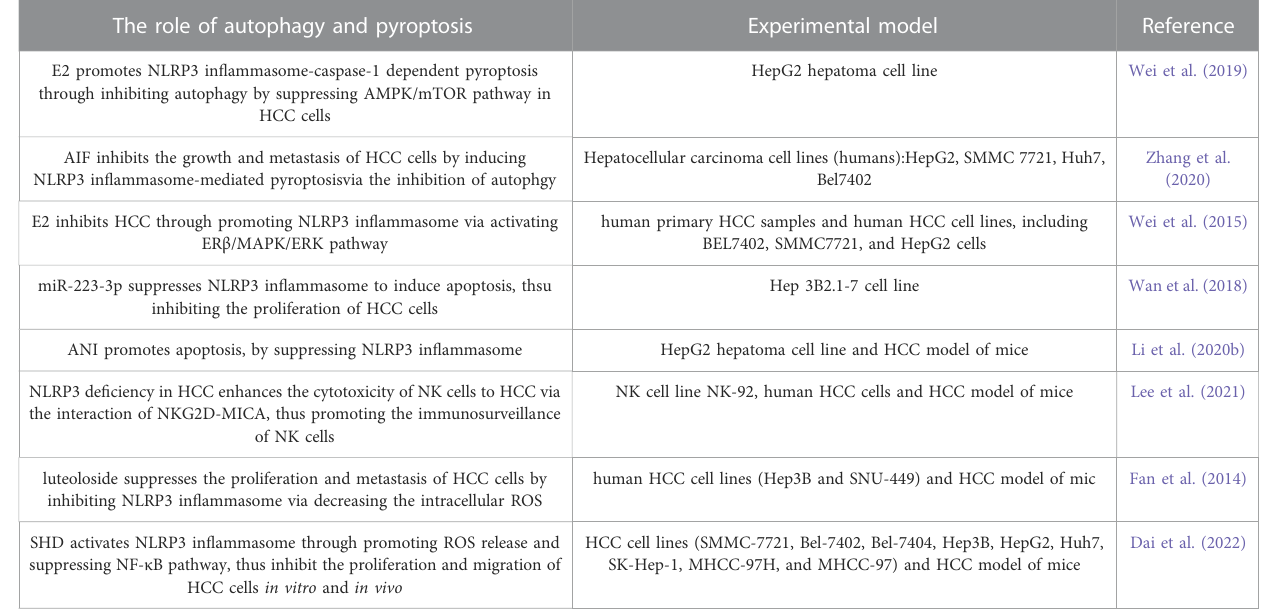
TABLE 1 The role of NLRP3 in fl amasome in hepatocellular carcinoma. The role of autophagy and